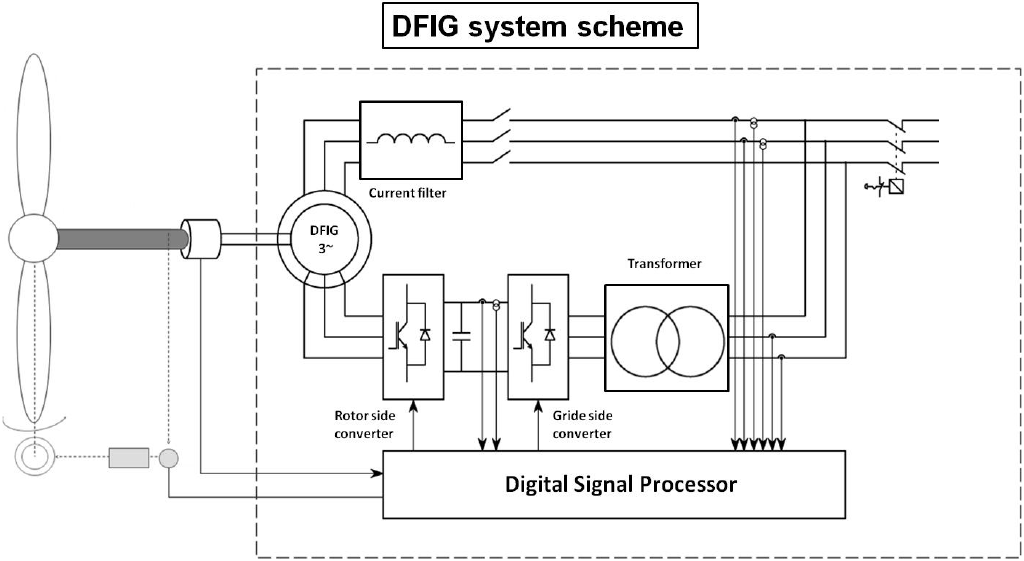
Figure 1. DFIG system connected to the grid.